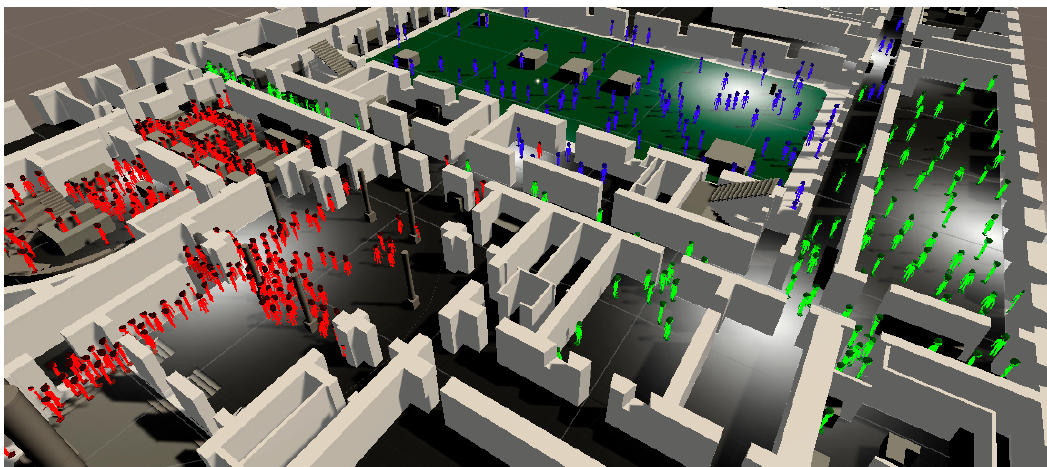
Figure 11. Human motion sensors simulation integrated into the system, to create a friendly interaction model for common users, by colouring the avatars with blue for low temperature, green for good temperature, and red for high temperature rooms.